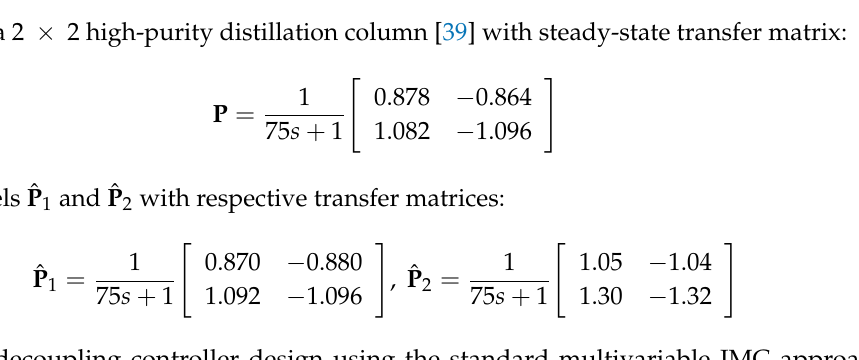
Figure 6. Closed-loop output response for step change in the set point of Output-1 ( y sp Figure 6. Closed ‐ loop output response for step change in the set point of Output ‐ 1 ( no change in the set point of Output-2 ( y sp change in the set point of Output ‐ 2 ( (bottom), (bottom), respectively.